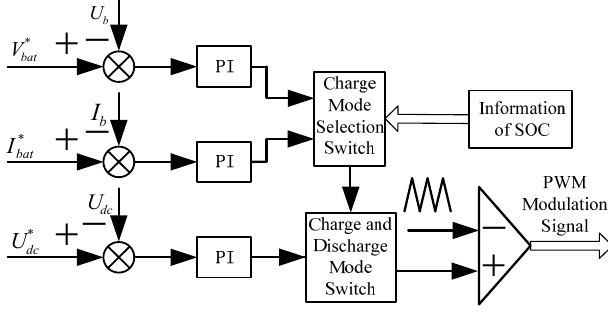
Figure 3. The control strategy block diagram of battery-side converter.